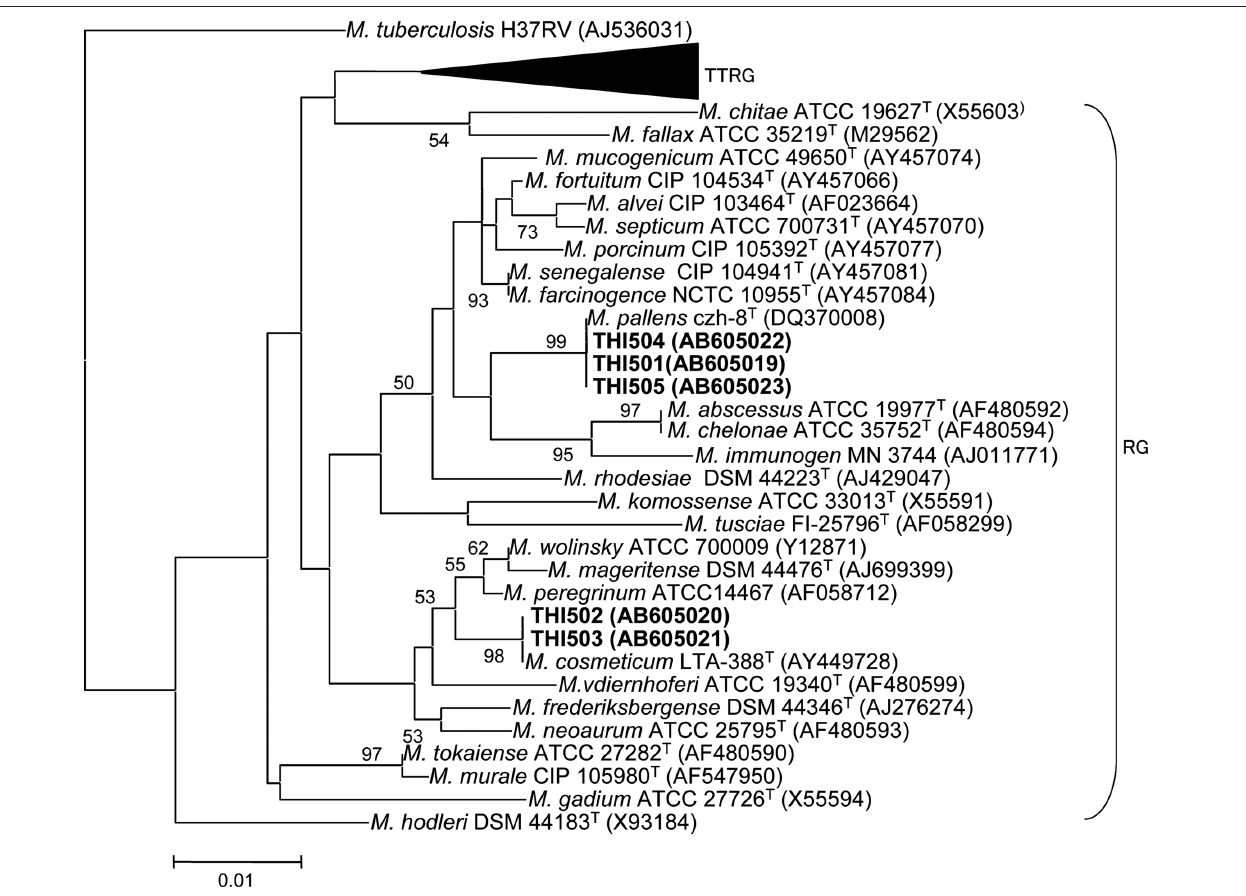
FiguRe 1 | Phylogenetic relationship between the five sulfur-oxidizing isolates and other rapid growing Mycobacterium species based on a comparison of their 16S rRNA gene sequences. A slow-growing species, M. tuberculosis , was included as the outgroup. GenBank accession numbers